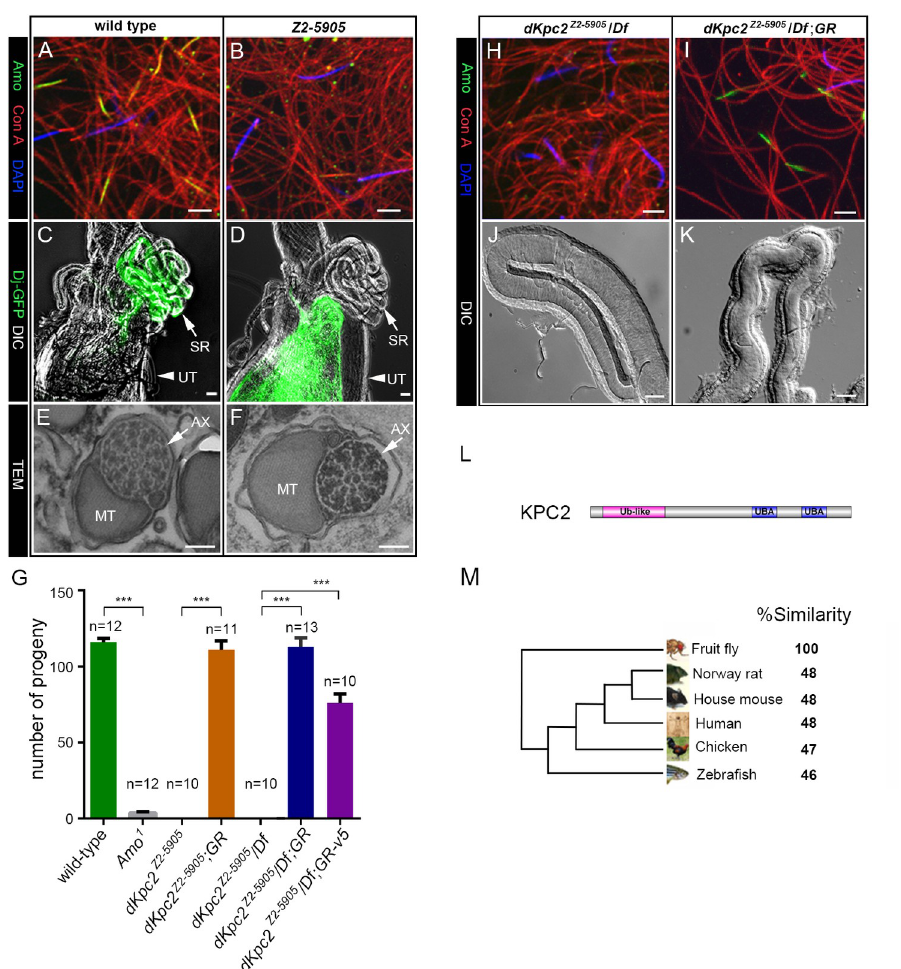
Fig 1. The Drosophila homolog of KPC2 is required for sperm tail localization of AMO. (A-B) Sperm stained with anti-Amo: green, concanavalin A: red, DAPI: blue. Amo is missing from the sperm tail in Z2-5905 sperm (B). Scale bars: 5 μ m. (C-D) Wild type female reproductive tracts dissected after mating with dj- GFP males (C) or Z2-5905; dj- GFP males (D). DIC and fluorescence images are super-imposed. Wild type sperm are found in the seminal receptacle (SR) while Z2-5905 mutant sperm are restricted to the uterus (UT). Scale bars: 100 μ m. (E-F) Representative electron microscopy images from wild type (E) and Z2-5905 (F) sperm. Scale bars: 100 nm. MT: mitochondria AX: axoneme. (G) Fertility tests with males of the indicated genotypes mated to wild type females. The male fertility defect in Z2-5905 mutants is rescued by a CG11025 genomic rescue (GR) construct with or without a V5 tag. The number of tests per genotype is denoted above the bars. Df: deficiency. ��� p < 0.001. (H-I) Sperm stained with anti-Amo: green, concanavalin A: red, DAPI: blue. Scale bars: 5 μ m. (J-K) Representative DIC images of wild type seminal receptacles dissected after mating with Z2-5905 males (J) or Z2-5905 males with a genomic rescue (K). The genomic construct rescues both Amo localization and sperm storage. Scale bars: 20 μ m. (L) Predicted domain structure of all three KPC2 isoforms showing an N-terminal ubiquitin like domain (Ub-like) and two C-terminal ubiquitin associated domains (UBA). (M) Phylogenetic tree demonstrates homology between Drosophila KPC2 and related proteins. We analyzed the predicted protein sequence of Transcripts B and C, which differ only at their amino termini, with Isoform C being 126 amino acids longer. Both transcripts encode polypeptides with two C-terminal ubiquitin associated (UBA) domains and an N-terminal ubiquitin-like domain (Fig 1L) . Blast analysis suggested that CG11025 encodes the fly homo- logue of a vertebrate gene, UBAC1 , also known as KPC2 . Isoform B is 30% identical and 48% similar to human KPC2 (E value 2e -35 ) (Fig 1M) . KPC2 is an adaptor that forms part of the